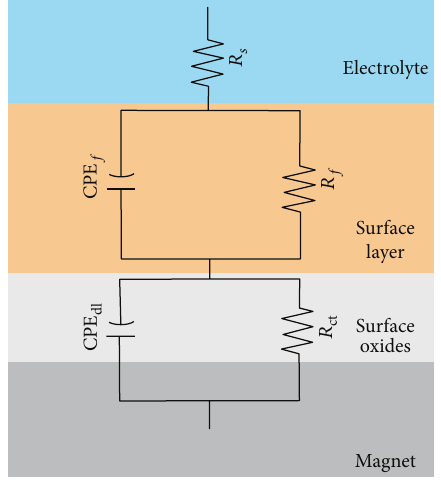
Figure 17: Equivalent circuit for permanent magnets corroded in 3.5% NaCl solution at 25 ∘ C from 3 to 24 hours.